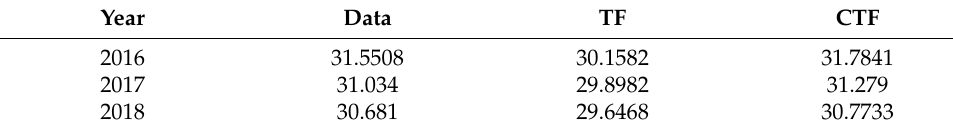
Figure 3. Real data vs. trend function and conditional trend function. Table 2. Forecasted values by